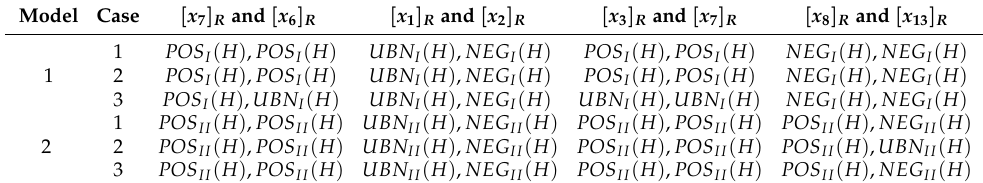
Table 10. Analysis of the advantages of Models 1 and